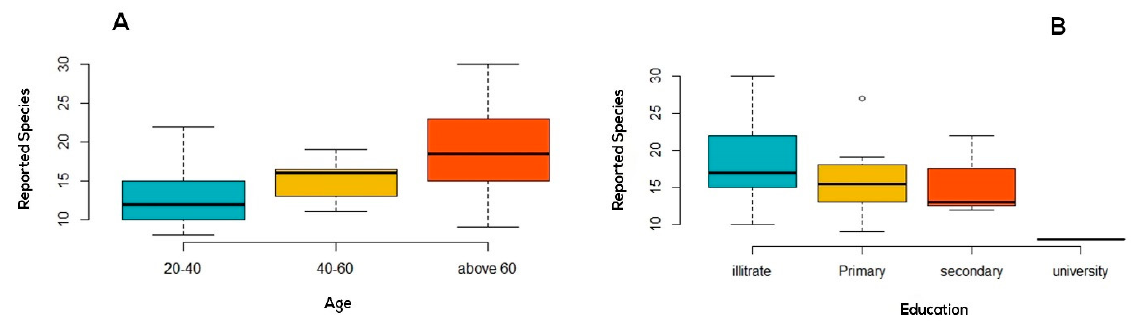
Figure 3. Informant’s competence according to the number of ethnospecies he/she mentioned by ( A ): Age and ( B ): Educa- tion Level.